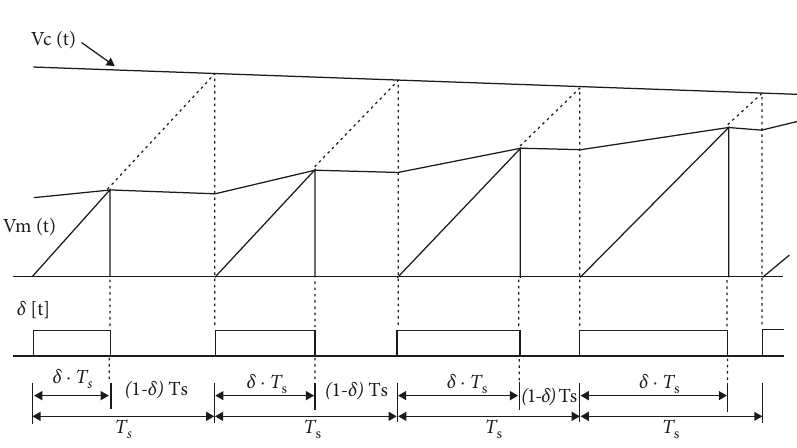
Figure 3: Overall control structure.